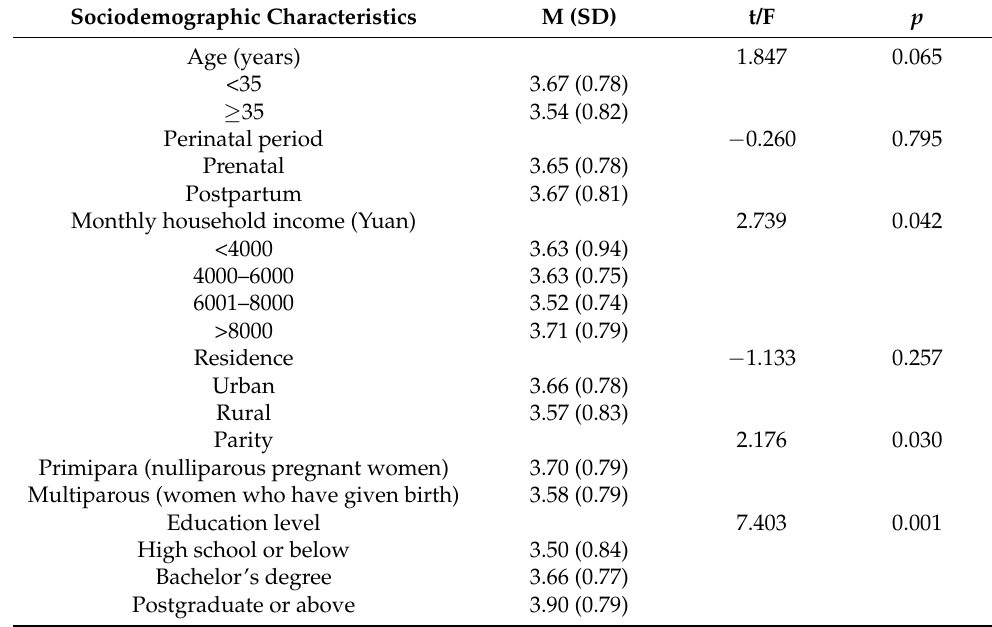
Table 2. Comparison of the help-seeking intention for depression in perinatal women ( n =